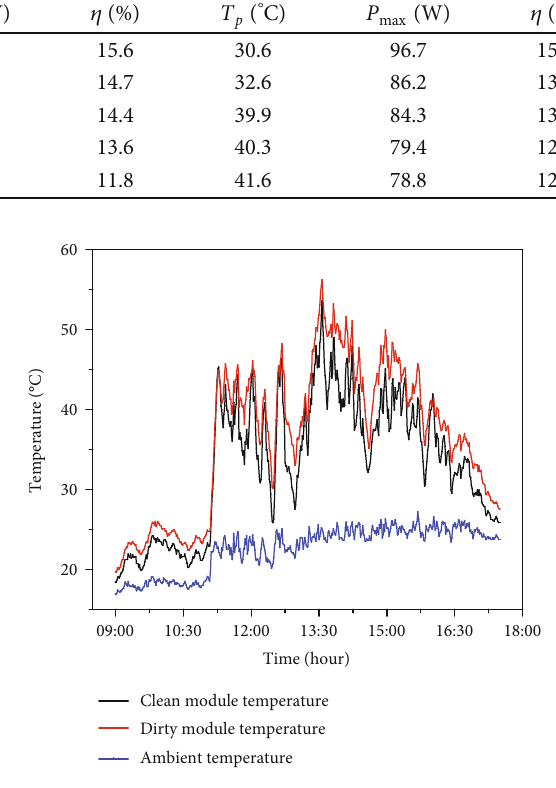
Figure 6: Ambient air and PV module operating